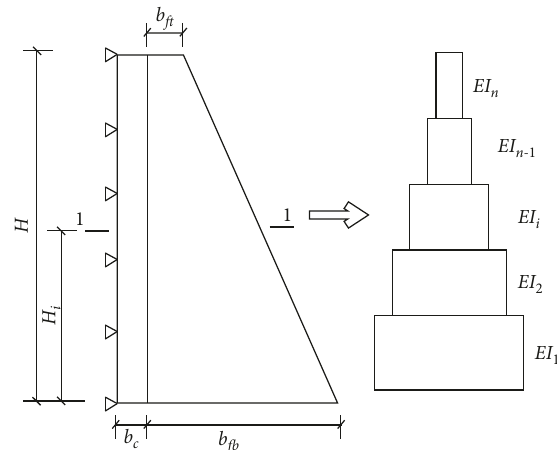
Figure 2: Diagram of equivalent stiffness of grille column and counterfort walls.